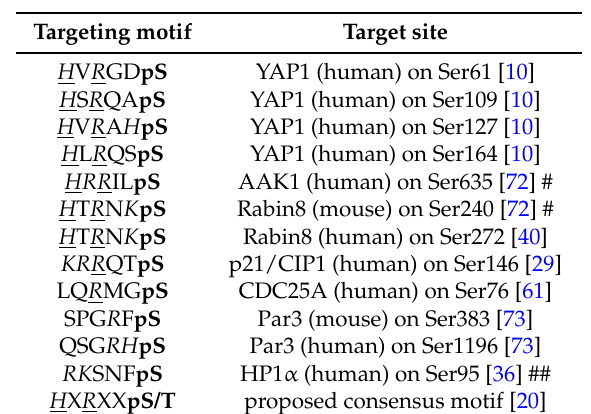
Table 1. Summary of targeting motifs of NDR1/2 substrates in mammalian cells.